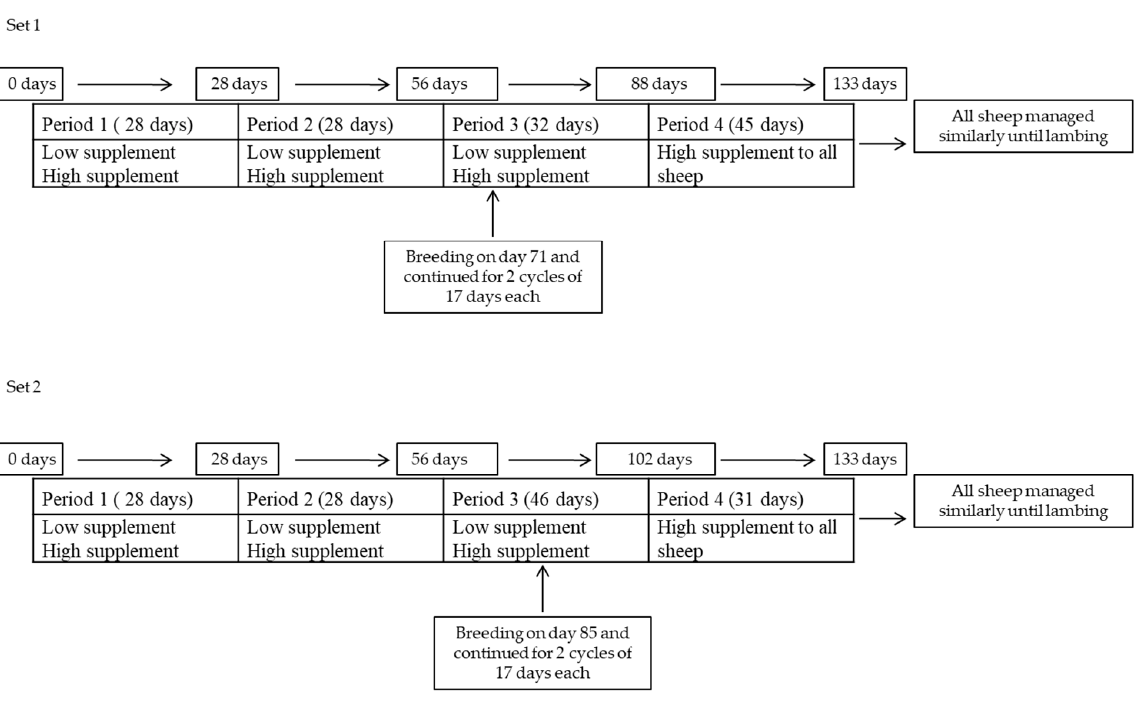
Figure 2. Two supplements fed to three breeds of sheep during different periods. Period 3 was 32 and 46 days for sets 1 and 2, respectively. Hence, supplement treat- ments were imposed for 88 and 102 days for sets 1 and 2, respectively. Breeding began on days 71 and 85 for sets 1 and 2 and, thus, supplement treatments continued for 17 days after the breeding period was initiated. In period 4, all groups were given the HS supplement treatment regime, which was 45 and 31 days for sets 1 and 2, respectively. The total breeding period was 34 days, with two 17-day cycles. As noted above, the two supplement treatments were imposed for the first cycle, whereas all animals were switched to the HS supplement treatment during the second cycle. Four rams of each breed divided into two sets were used, which were previously subjected to and passed a breeding soundness examination. Estrus synchronization was employed, with a controlled internal drug release (CIDR) vaginal device (EAZI-breed ™ CIDR ® , Pfizer Animal Health, Auckland, New Zealand) inserted on day 0 (on day 61 for set 1 and day 75 for set 2 after supplementation started) of estrus synchronization and 10 mg of PGF2 α (Lutalyse, 10 mg dinoprost tromethamine i.m., Zoetis Animal Health, Parsippany-Troy Hills, NJ, USA) was intramuscularly injected 9 days later (on day 70 for set 1 and day 84 for set 2 after supplementation started). On day 10 (on day 71 for set 1 and day 85 for set 2 after supplementation started), the CIDR was removed, at which time two rams of each breed fitted with marking harnesses were introduced into one of the two pens per breed-supplement treatment. Estrus and breeding markings were checked twice daily at 08:00 and 16:00. Non-return to estrus was assumed when ewes were not marked during the second cycle with a ram. After 17 days with the first group of ewes, the rams were moved with the second group and stayed with them for two cycles.